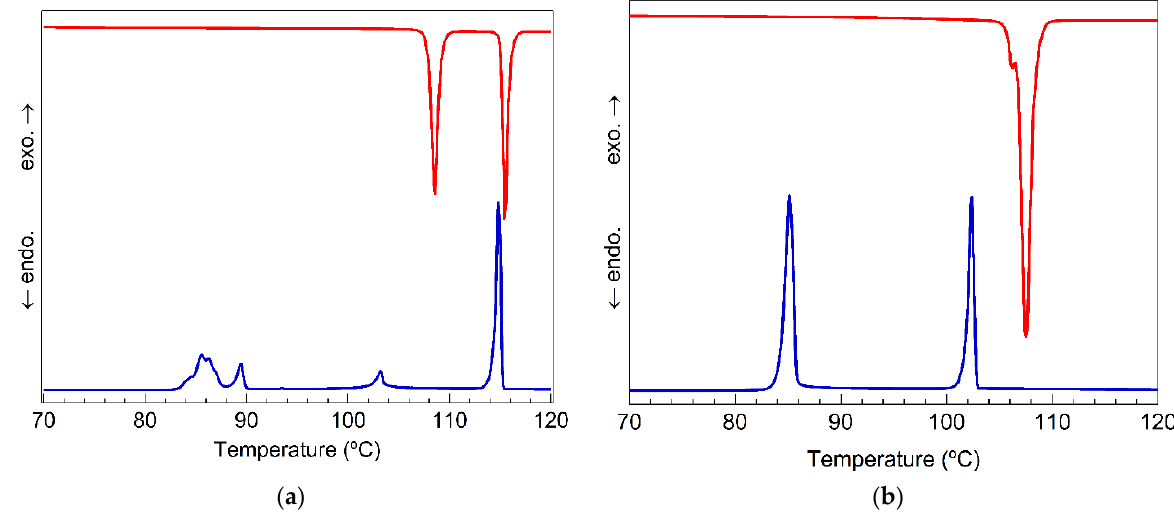
Figure 3. Differential scanning calorimetry (DSC) thermograms of ( a ) 5-BPTMS and ( b ) 6-BPTMS (red, 2nd heating scan; blue, 2nd cooling scan; scanning rate, 5 °C min –1 ).